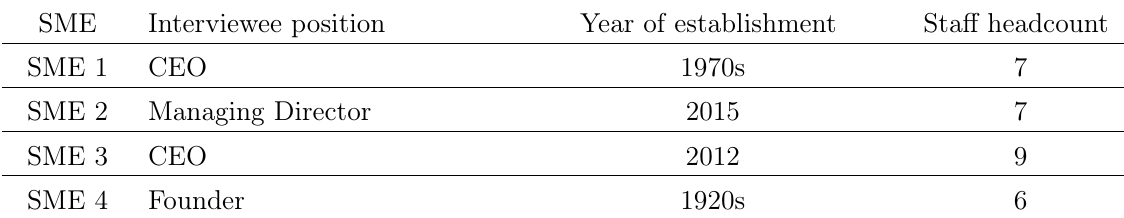
Table 3. Brief overview of interviewees and SMEs SME Interviewee position Year of establishment SME 1 CEO SME 2 Managing Director SME 3 CEO SME 4